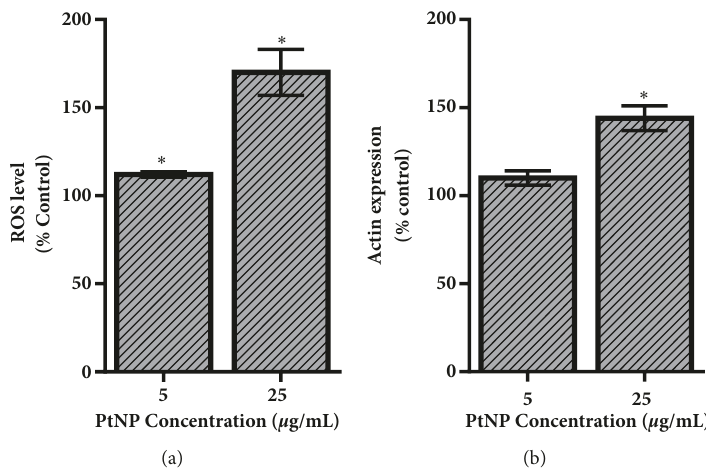
Figure 3: PtNP-induced stress response within the HepG2 cell model. (a) ROS and (b) actin levels were measured within HepG2 cells following a 24-hour exposure to varying dosages of PtNPs. Both endpoints demonstrated a dose-dependent increase in stress activation. Data represents 3 independent trials with ∗ denoting statistical significance from untreated controls ( p < 0.05).